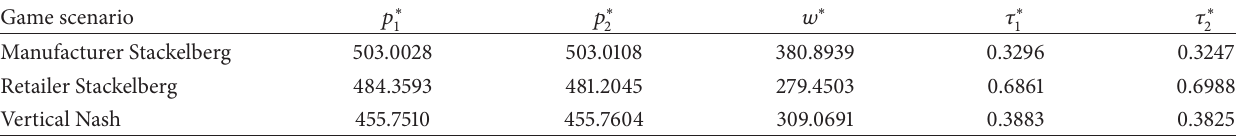
Table 3: Optimal decisions of retail prices, wholesale price, and collecting